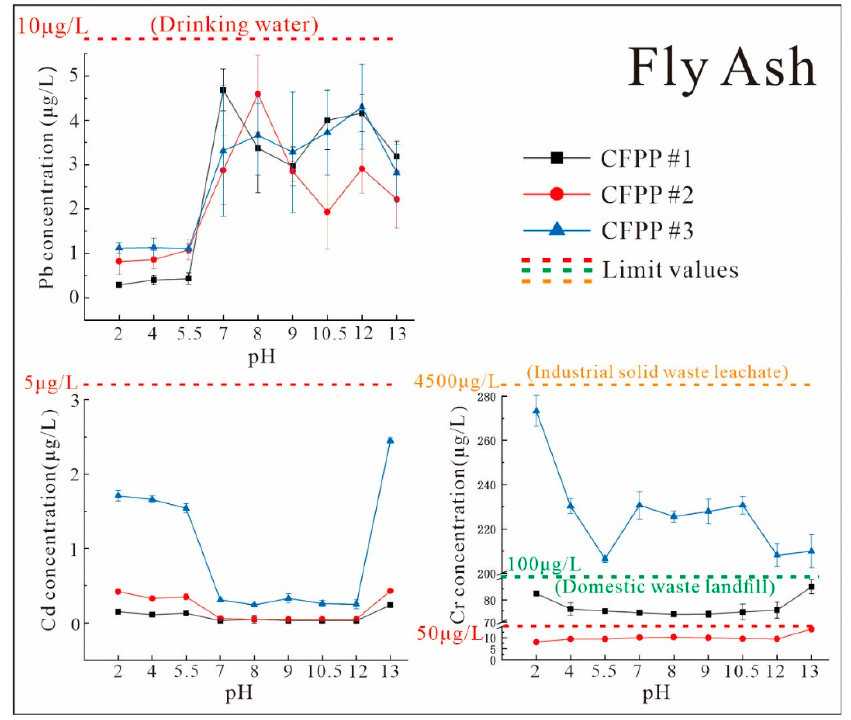
Figure 5. Characteristics of heavy metals leaching from coal FA at various pH values and a constant solid–liquid ratio of 1:10 (The dashed lines indicate the pollution concentration limits for different standards.).